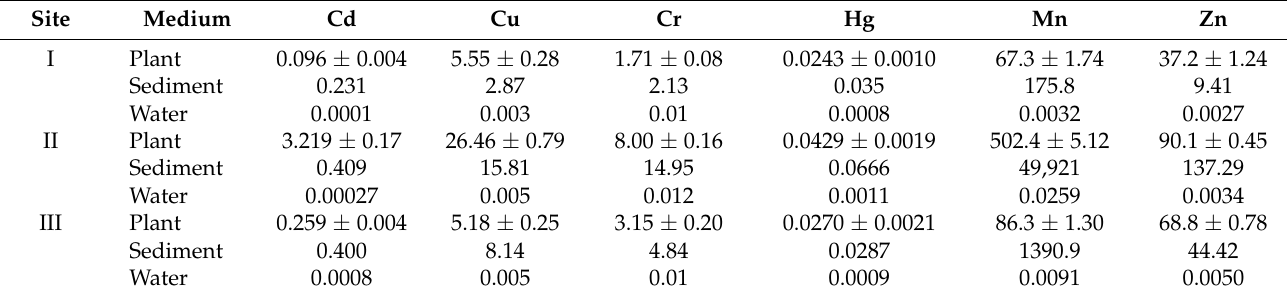
Table 3. Distribution of heavy metal in G. densa , sediments and water collected from 3